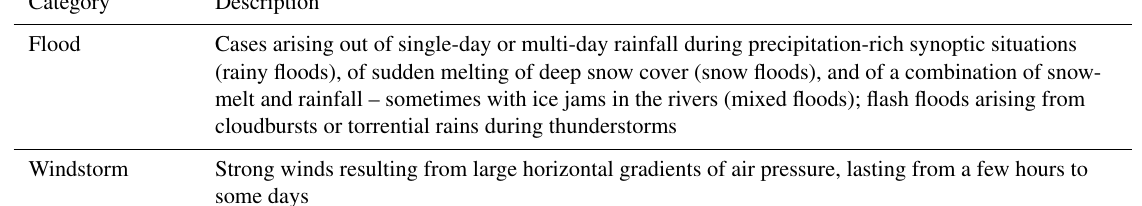
Table 1. Categories of weather-related fatalities and their short description.